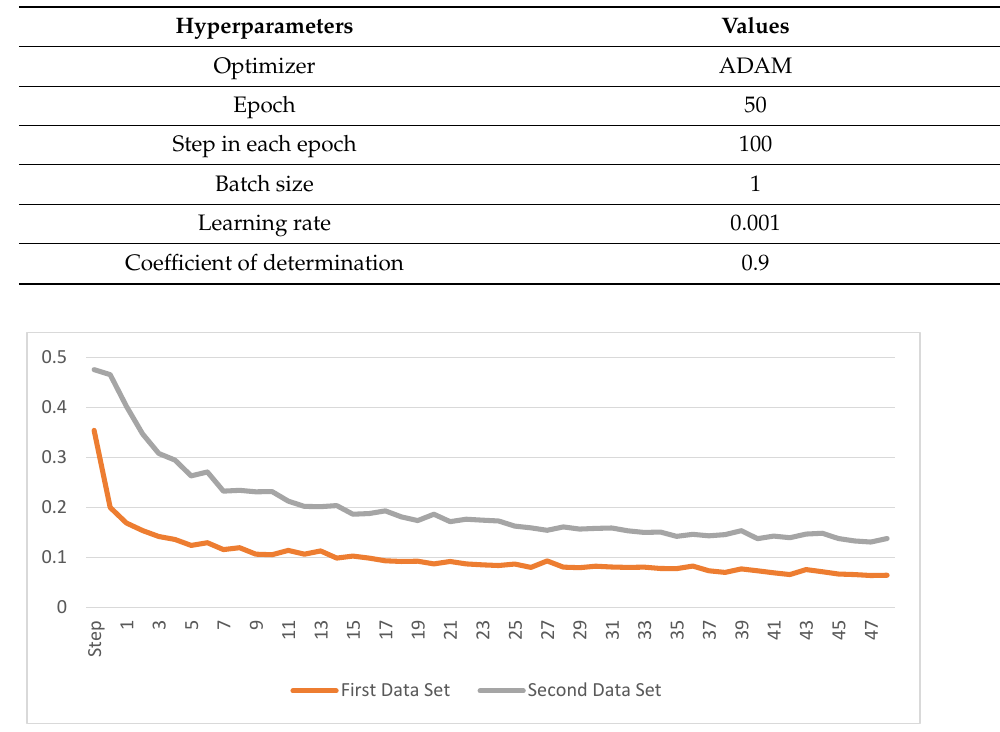
Figure 6. The change of the training loss values.